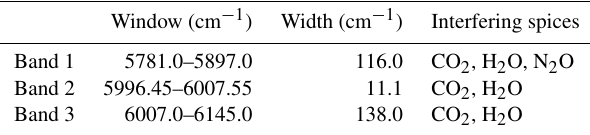
Table 3. The retrieval windows used in the GGG2014